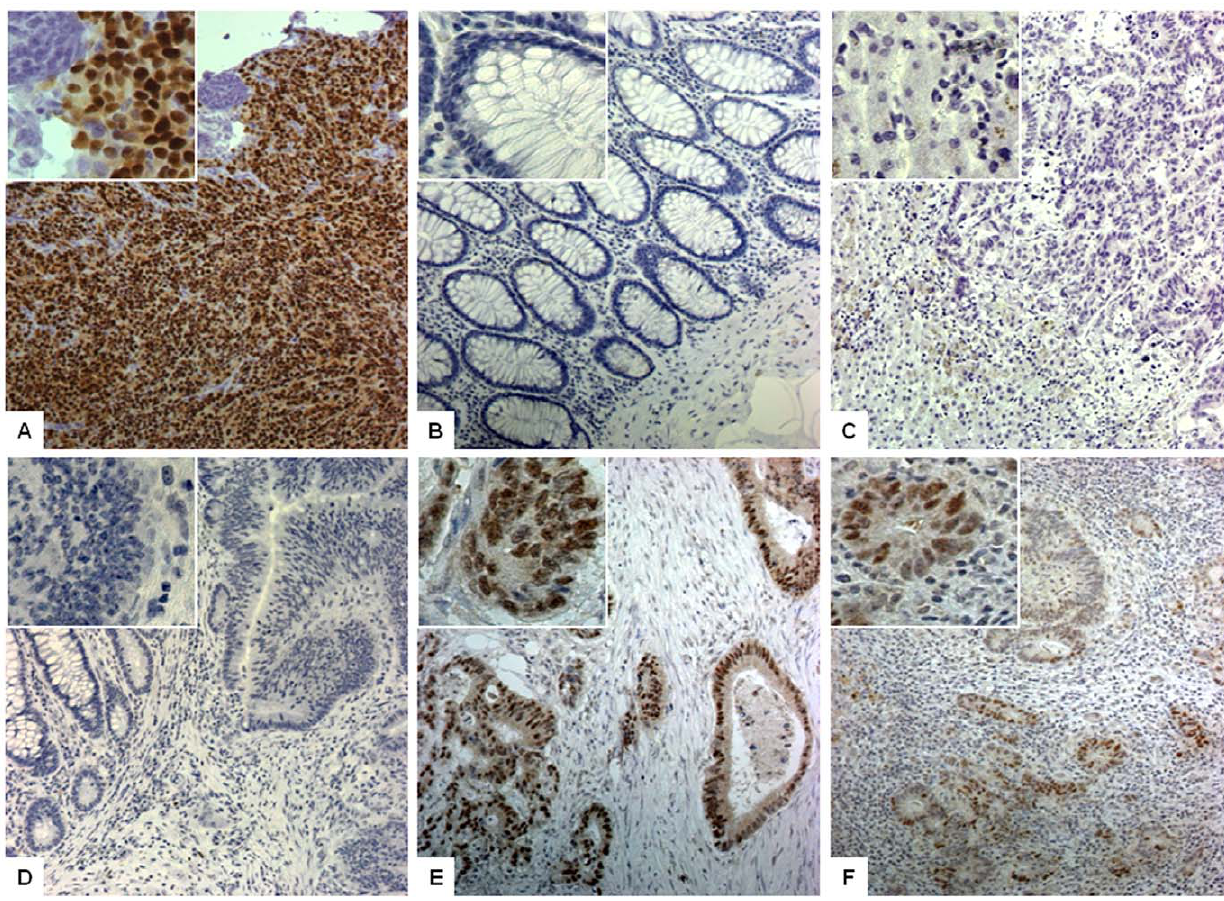
Figure 6. JCV T-Ag expression in primary CRC tumors and in liver metastasis. Staining was performed with Pab416 antibody against SV40 T-Ag with cross reactivity to JCV T-Ag. Images were obtained at 100 6 and 400 6 magnification (as shown in the insets within each photomicrograph) (A) Positive control staining from hamster brain tissue infected with JC virus shows strong nuclear T-Ag expression. Normal colonic mucosa (B) and liver hepatocytes (C) showed no JCV T-Ag expression and were used as negative controls with each staining. (D) A representative example of a CRC and colonic mucosa with no T-Ag expression. (E) A photomicrograph indicating strong nuclear T-Ag expression in invasive primary colonic tumor (F) The image illustrates T-Ag-specific expression in liver metastasis in cancer cells but no expression in surrounding normal liver